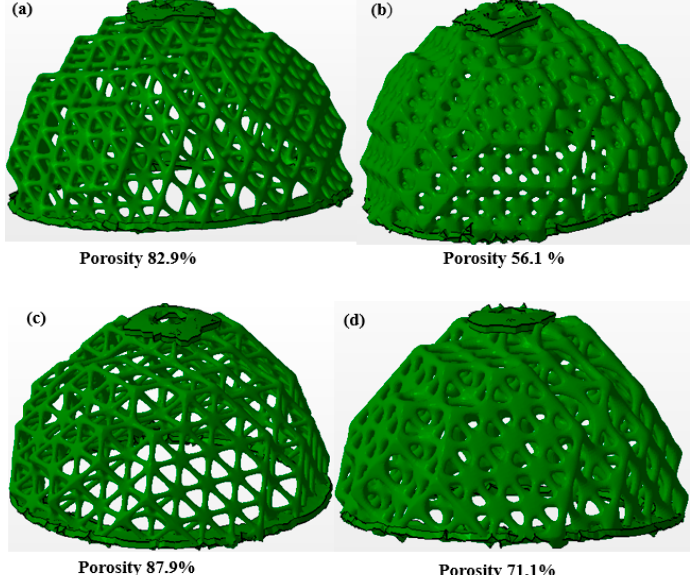
Figure 4. The schematic illustration showing the design process of cellular implant structure. ( a ) Solid AC CAD, ( b ) vintiles lattice topology, and ( c ) cellular implant AC.